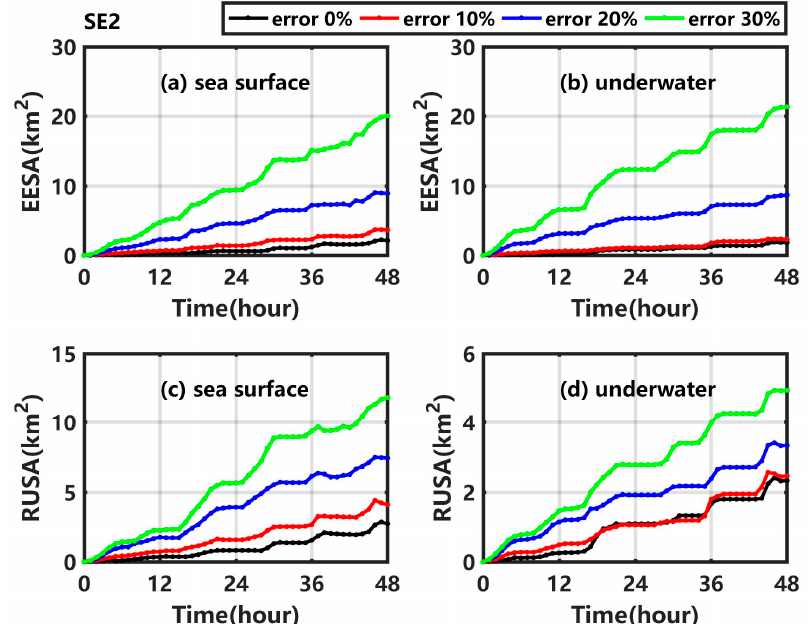
Figure 9. ( a ) EESA at the sea surface, ( b ) underwater EESA, ( c ) RUSA at the sea surface and ( d ) underwater RUSA in Exp1 (black line), SE2_1 (red line), SE2_2 (blue line), and SE2_3 (green line).